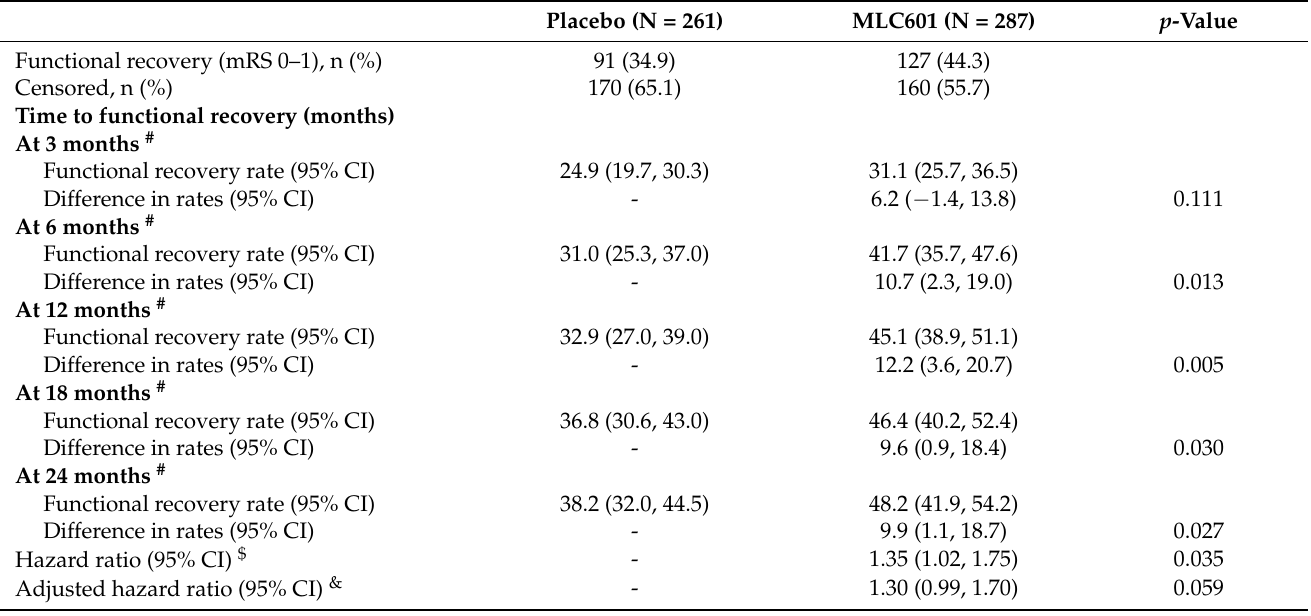
Table 3. Time to achieve functional recovery over 2 years in subgroups with poor prognostic factors: